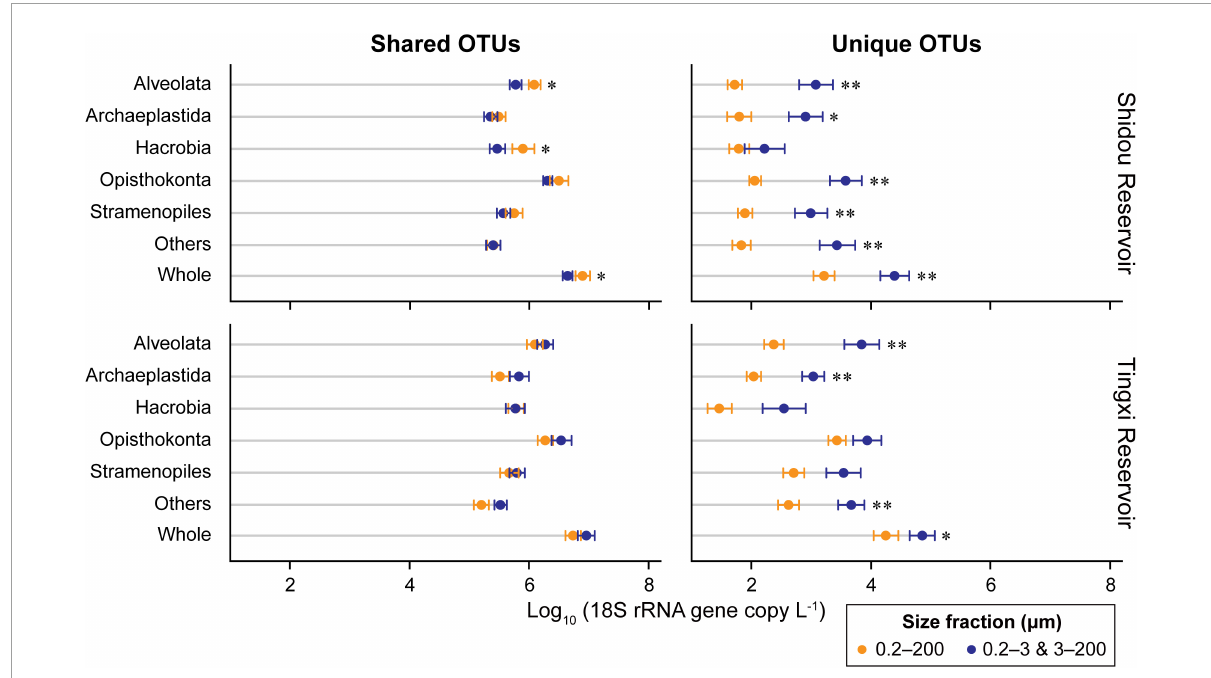
FIGURE3 Comparison of 18S rRNA gene copy abundance of different supergroups between two size-fractionated plankton communities. The OTUs were defined at 97% sequence similarity threshold. Statistical analysis is non-parametric Mann–Whitney U test ( ∗ P < 0.05, ∗∗ P < 0.01). The error bar represents the standard error of OTU occurrences in all samples. Others includes Amoebozoa, Apusozoa, Excavata, and Rhizaria.